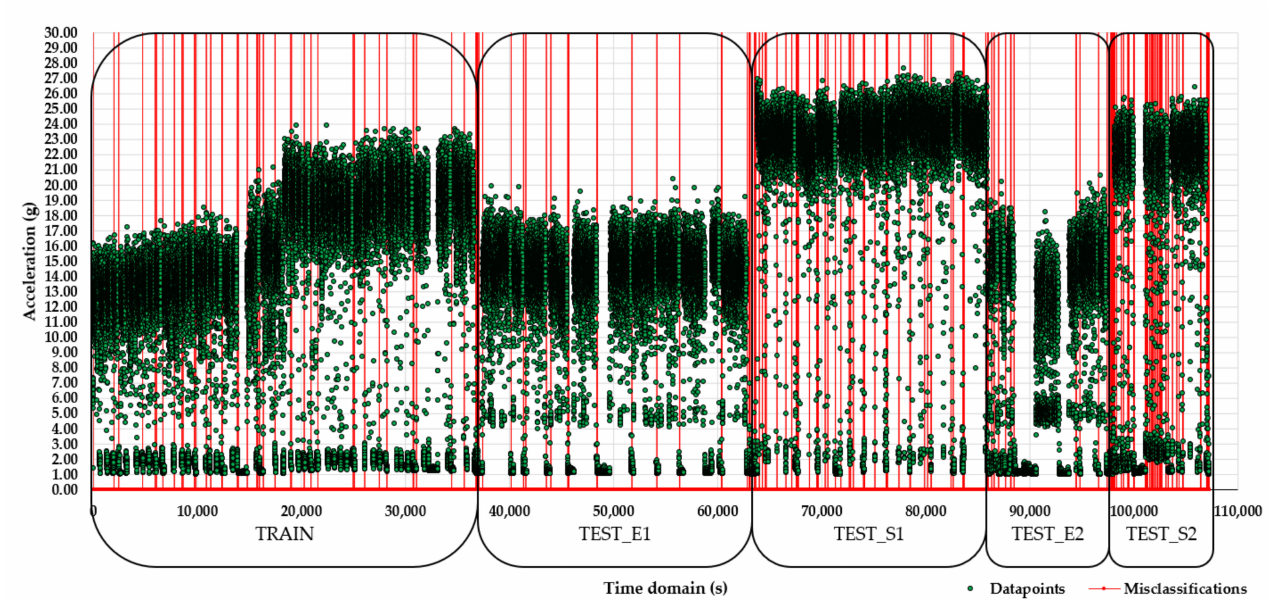
Figure 5. Distribution of misclassifications in the training (TRAIN) and testing (TEST_E1, TEST_S1, TEST_E2, TEST_S2) datasets for a regularization term ( α ) set at 0.0001. Legend: green points stand for the Euclidian Norm (EN); red lines stand for correctly classified datapoints when drawn horizontally at an EN of 0, and for misclassified datapoints when drawn vertically. Note: for convenience the datasets were merged in their order of